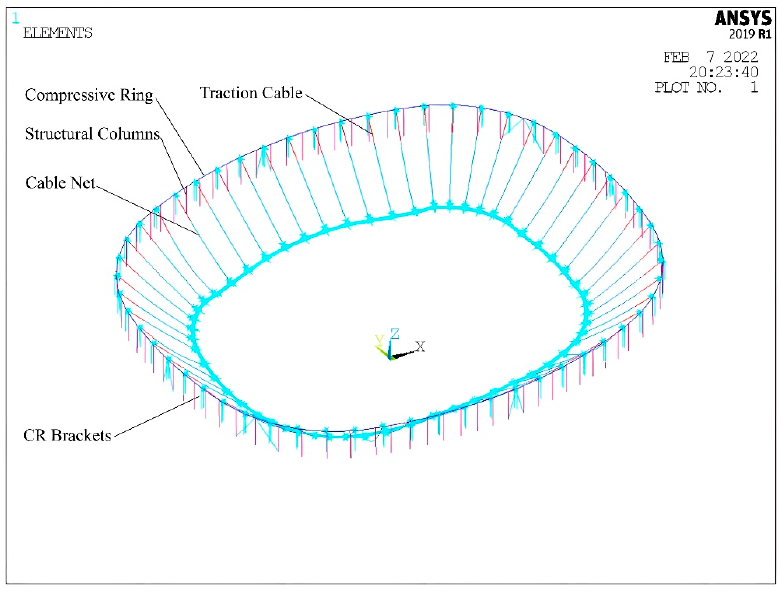
Figure 15. Traction lifting model (red lines indicate traction cables). Table 6. Calculation conditions during synchronous equal proportion integral lifting.